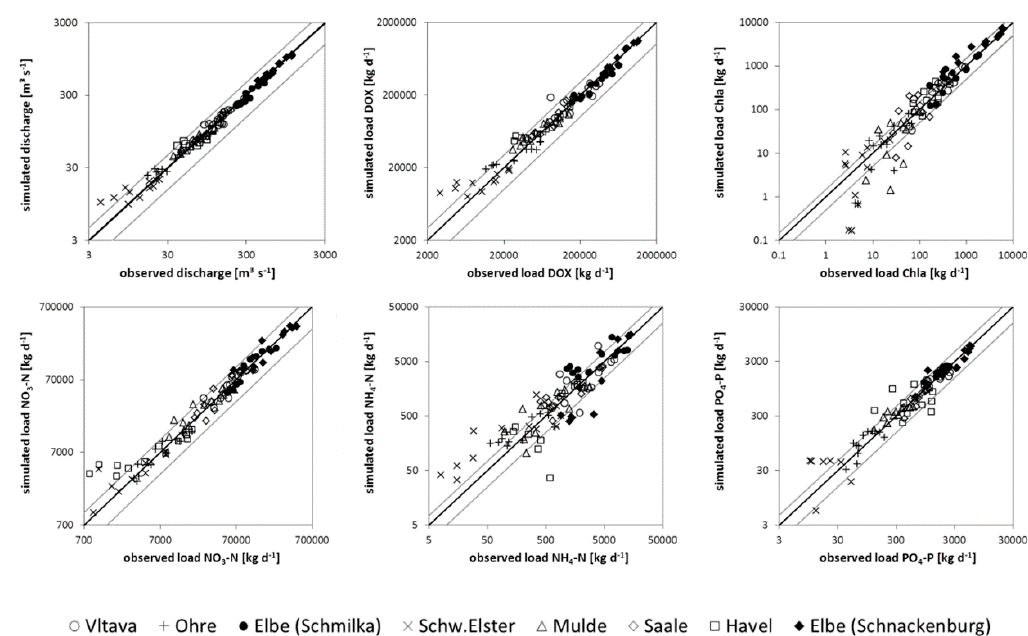
Figure 4. The long-term average monthly observed and simulated discharge and loads per tributary and at two selected Elbe gauges in the period 2001–2010 (diagonals: black—perfect fit, grey—± 50% intervals).